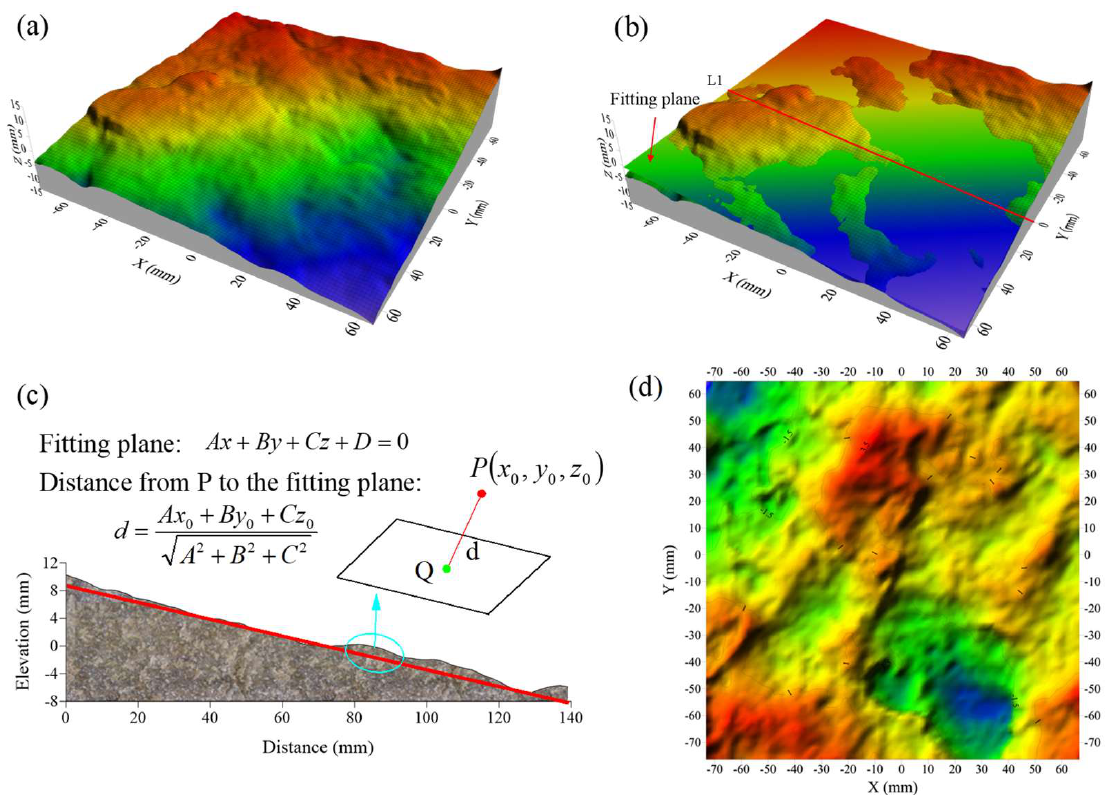
Figure 3. Method for removing the inclination features of rock joints. ( a ) Grid data processed by denoising and minimum curvature interpolation; ( b ) Fitting plane; ( c ) Calculating the distance from original point cloud to the fitting plane; ( d ) Joint without inclined features.